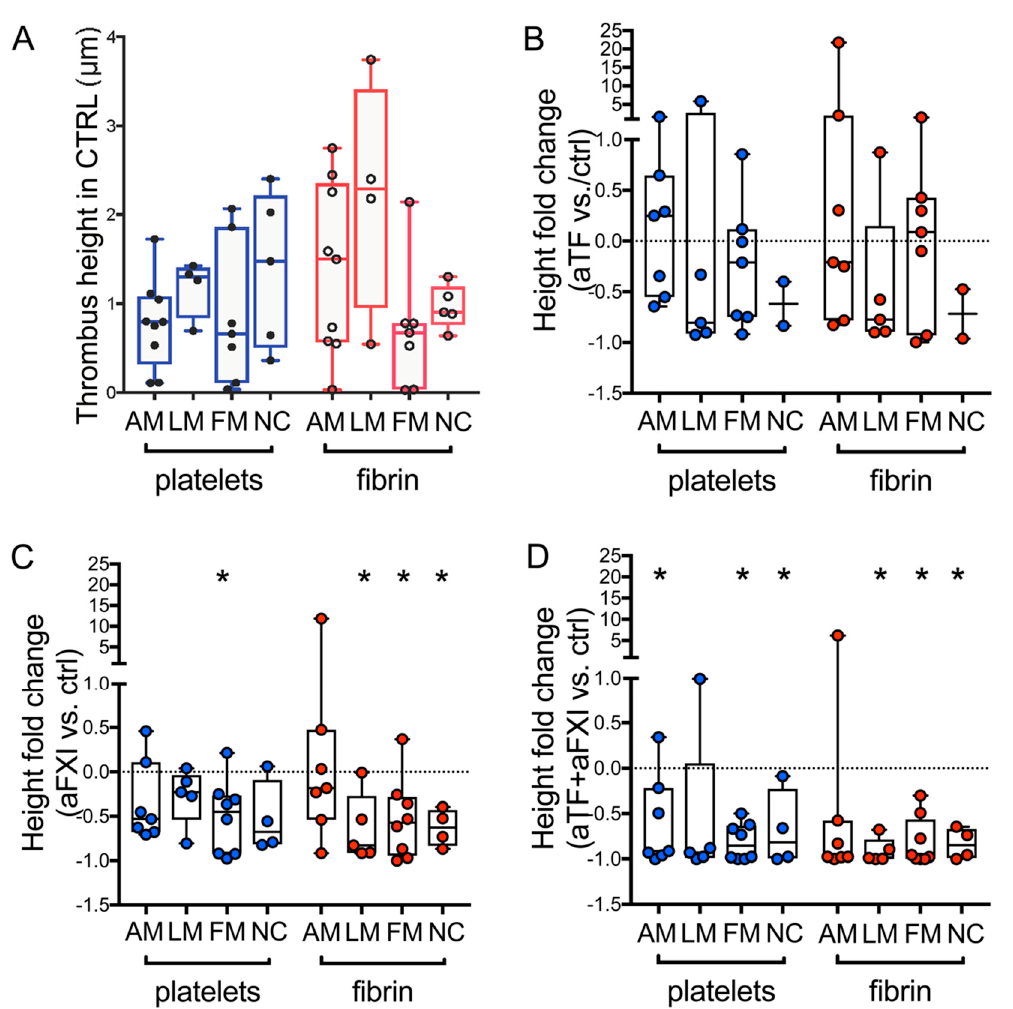
Figure 3. Influence of coagulation pathway blockades on thrombus formation over CPL media subtypes. Comparison of platelet aggregates (blue) and fibrin deposition (red) over the media sub-layers of 11 CPL in blood flow experiments using control blood ( A ). Thrombus formation in the presence either of aTF ( B ), or aFXI ( C ), or aTF + aFXI ( D ) is quantified in fibro-calcific areas (FM), necrotic core (NC), lipoproteins and/or foam cell-rich areas (LM), or minimally altered (AM) fields of media from 7 CPL. Degree of inhibition (fold changes in thrombus height vs. CTRL) is presented. The dashed line at 0 indicates the absence of changes. In each panel the data are displayed as boxes (5–95 percentile), and dots indicate the mean value from ≥ 3 fields/sample. Asterisks in ( B – D ) indicate significant differences in fold change vs. CTRL for each media subtype, obtained by non-parametric Wilcoxon matched-pairs signed rank test (hypothetical value for inference = 0). * p values < 0.05 are considered significant. Not all the subtypes are detected in all the CPL.